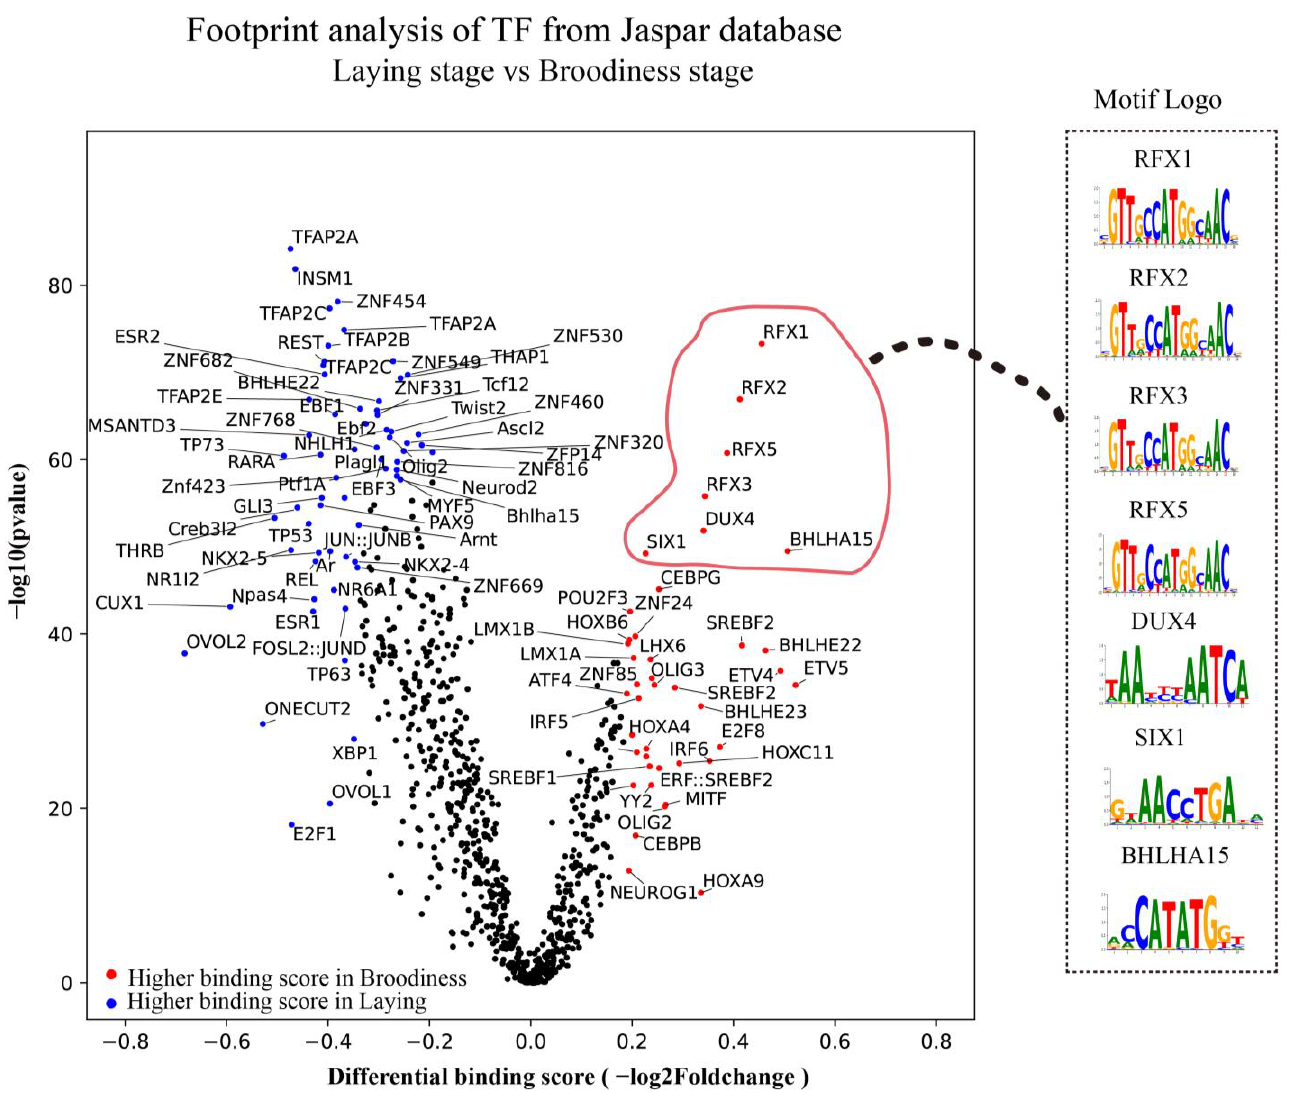
Figure 6. Pair-to-pair comparison of TF activity at different stages of reproductive development. Volcano plot shows differentially binding activity of − log10 ( p -value) (all provided by TOBIAS software) for all TF motifs investigated; each point represents a motif. All TFs with − log10 ( p -value) above the 95% quantile or differential binding scores smaller/larger than the 5% and 95% quantiles (top 5% in each direction) were considered differential binding TFs. For the laying stage, specific TFs are marked in blue, while specific factors of the broodiness stage are marked in red. Seven prominent examples from specific TFs in the broodiness stage are selected and illustrated on the right.